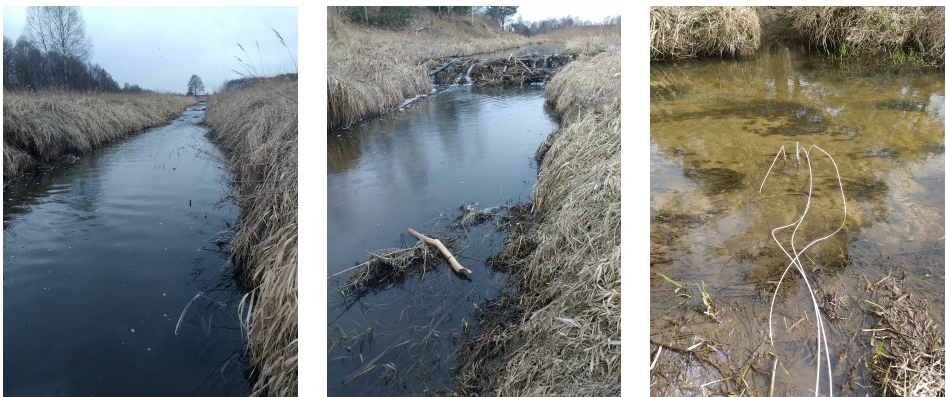
Figure 2. From the left: stretch R1–R2; beaver dam—picture taken looking upstream from point R3; hyporheic water sampler at point